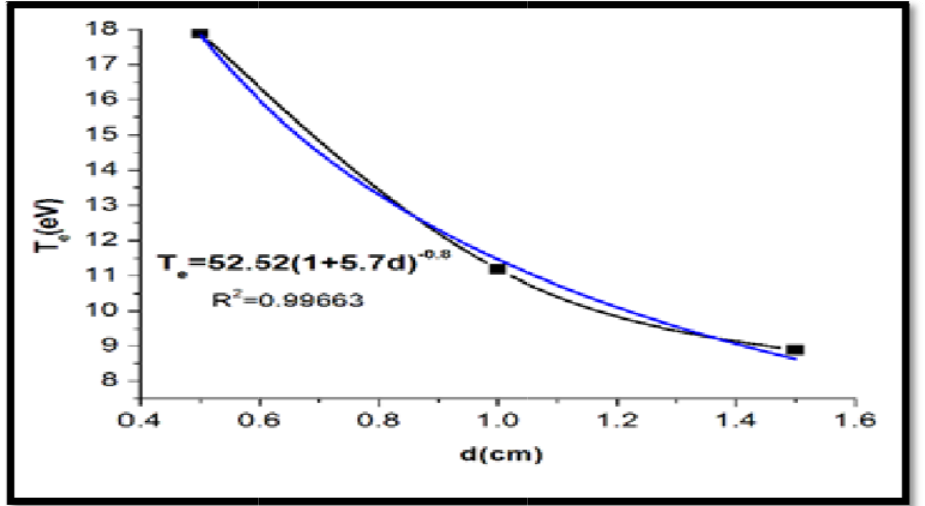
Fig. 4: Elect tron tempera ature versus N Nd:YAG lase er wavelength As the axial distance fr rom the SiO targ get surface increases the electro tem mperature d decreases